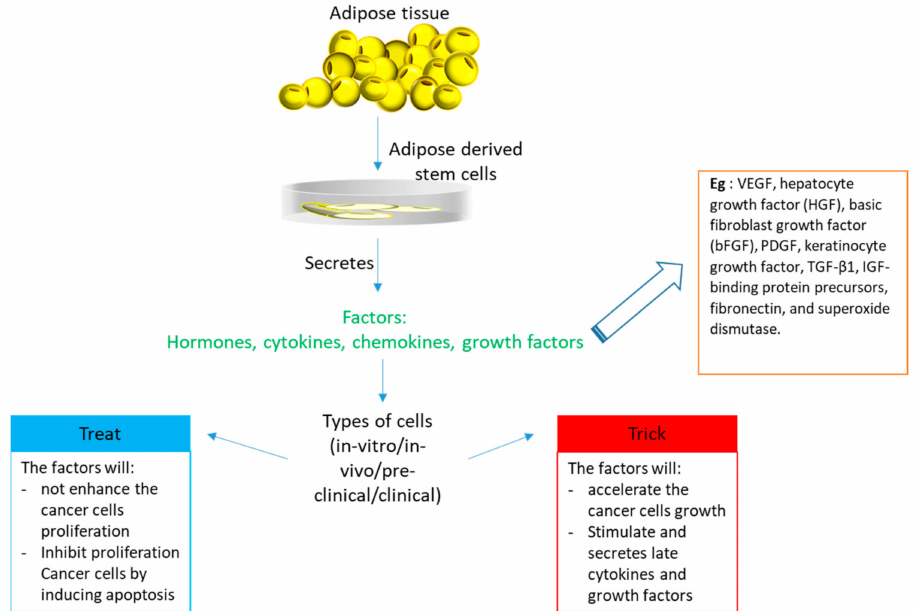
Figure 1. An overview of the therapeutic potential of adipose-derived stem cells for various